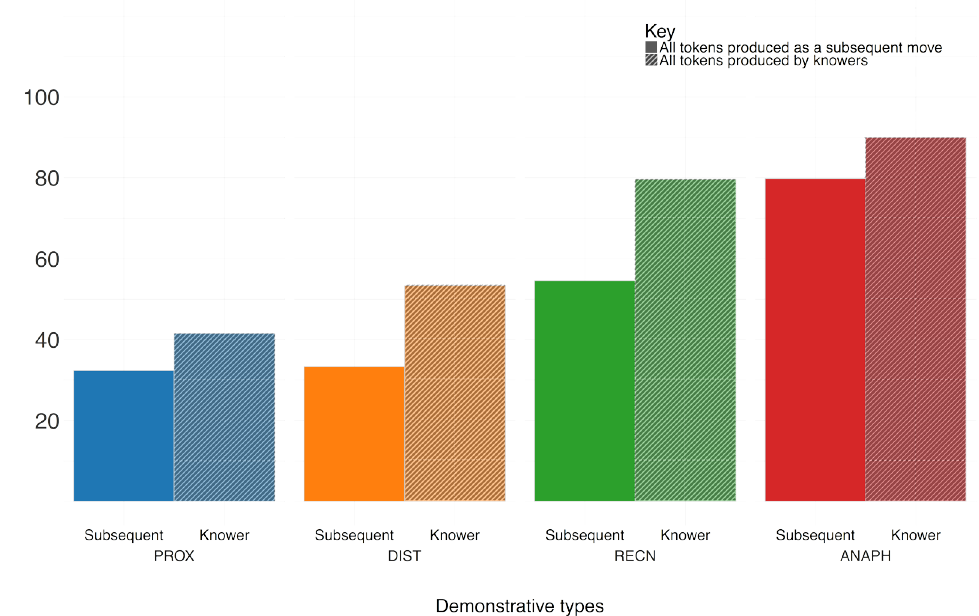
Figure 8: The proportion of demonstrative types (both with and/or without points) that occur in subsequent moves (solid bars), and as used by knowers (hatched